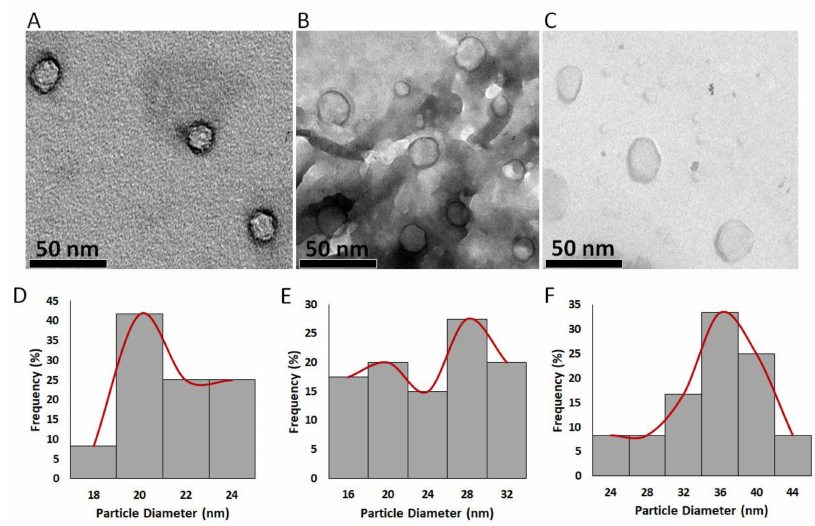
Figure 2. Transmission electron microscopy (TEM) images of ( A ) Pt NPs, ( B ) Pd NPs, and ( C ) Pt–Pd NPs greenly synthesized by P. harmala seed alkaloid fraction. Particle diameter (nm) histograms of ( D ) Pt NPs, ( E ) Pd NPs, and ( F ) Pt–Pd NPs created using the image processing program ImageJ (NIH,